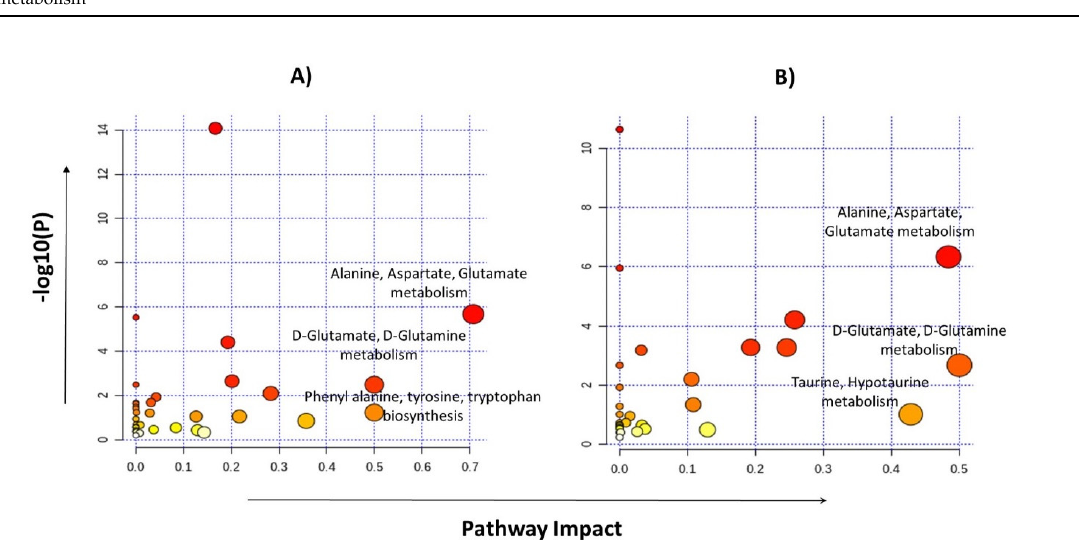
Figure 5. Pathway analysis performed by MetaboAnalyst using metabolites identified for glioma vs control group ( A ) and the LGG vs HGG group ( B ).